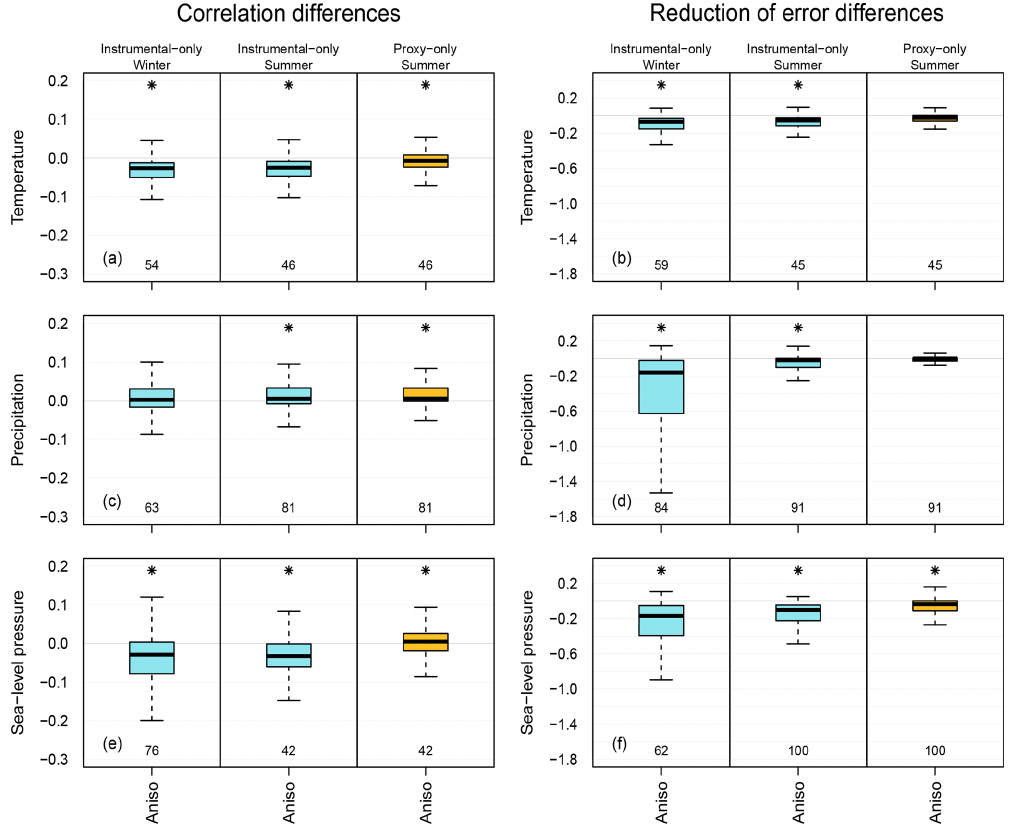
Figure 4. Difference between the aniso experiment and the original setup in terms of skill scores over the ENH region. Distributions of correlation values and of RE values are on the left and right figures, respectively. Distribution of temperature (a, b) , precipitation (c, d) and sea-level pressure (e, f) are shown. Blue color indicates the instrumental-only experiment and yellow indicates the proxy-only experiment. The midline of the box is the median. The lower (upper) border of the box is the first (third) quartile. The whiskers extend up to 1.5 times the interquartile range; beyond these distances, the number of outliers is given under the box plots. The grid boxes were not area weighted. The asterisk above the box indicates significant differences between the median of the experiment and the original